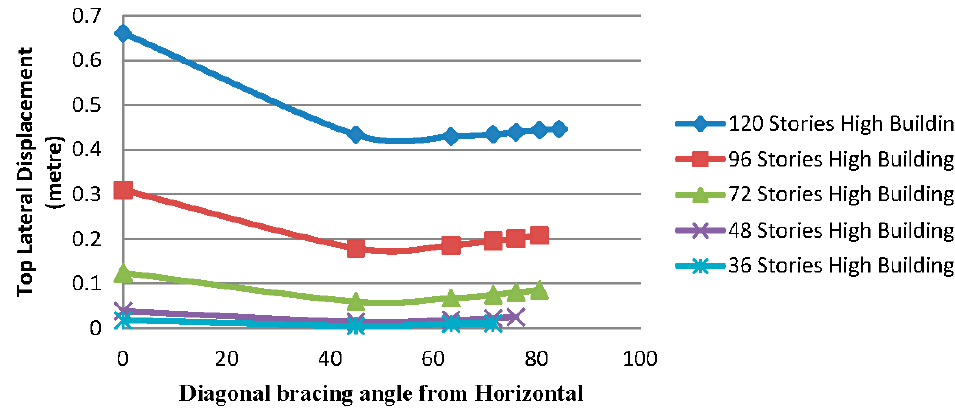
Figure 15. Top lateral deflection vs. varying angle of bracing system for buildings of Model 2.